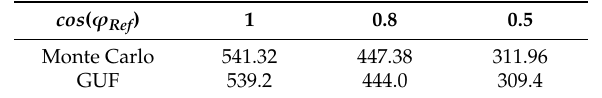
Table 3. Mean values of u ( P Ref ) / S for one standard uncertainty (equivalent to a coverage factor of